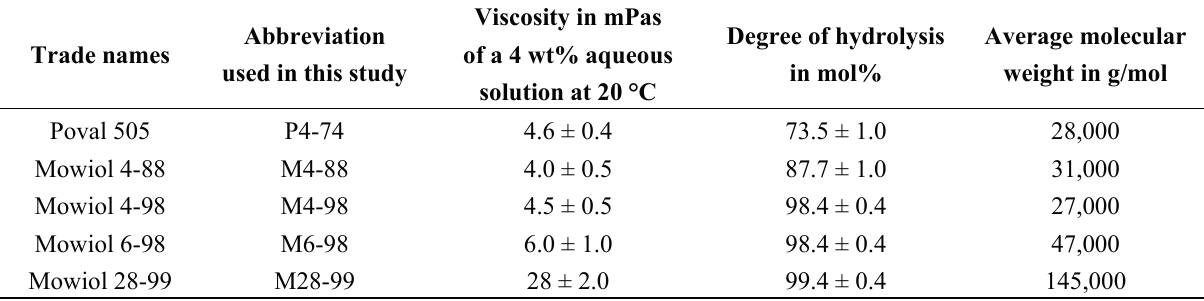
Table 2. Viscosity, degree of hydrolysis and mean average molecular weight of different types of PVOH (data provided by Kuraray).